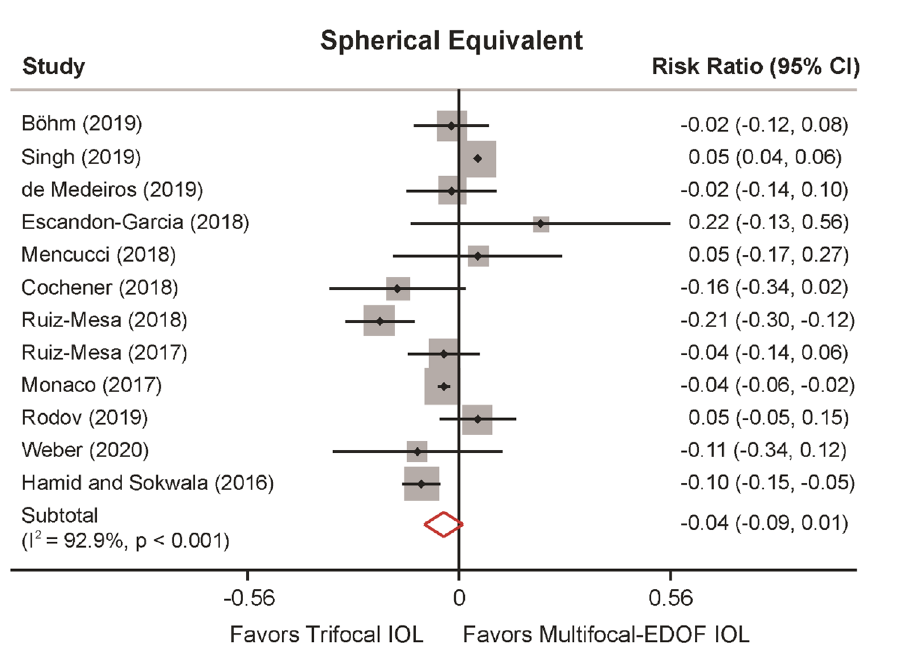
Figure 3. Spherical equivalent comparing trifocal and the hybrid multifocal-extended depth of focus (EDOF) intraocular lens